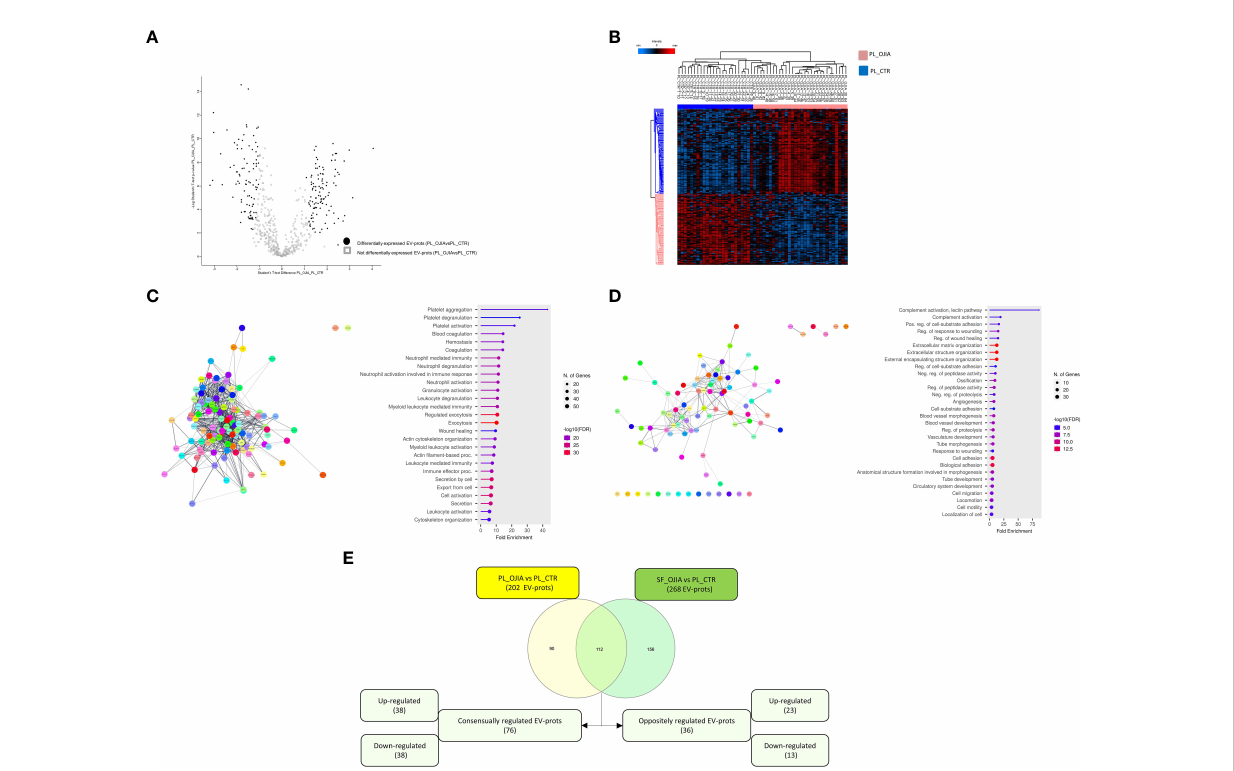
FIGURE 5 Comparative analysis of EV-prot expression pro fi les between PL_OJIA and PL_CTR specimens. EV-prot expression pro fi les were compared between the full sets of PL samples from new-onset OJIA patients and CTR children, and differences in the expression patterns were de fi ned. Differentially expressed EV-prots were subjected to network and functional enrichment analyses. (A) Volcano plot shows differentially expressed EV-prots between the two groups of samples. EV-prot expression levels are indicated as described in the legend of Figure 3B. On the left EV-prots downregulated and on the right those up-regulated in PL_OJIA respect to PL_CTR samples are shown. (B) Heat-map representation shows unsupervised hierarchical clustering analysis of signi fi cantly differentially expressed EV-prots in PL_OJIA vs PL_CTR samples. EV-prot expression levels are indicated as described in the legend of Figure 3B. The pink and blue bars above the columns distinguish the OJIA and CTR groups. The optimal association between two main clusters of EV-prots (indicated by the pink and blue bar on the left side) identi fi ed by the unsupervised hierarchical method and the PL_OJIA and PL_CTR groups of samples is shown. (C, D) Network and pathway enrichment analyses were carried out on up- (C) and down- (D) regulated EV-prots. Interaction networks among EV-prots and GO enriched biological processes are depicted as described in the legend of Figures 3C, D. (E) Venn diagram shows the number of common and exclusive differentially expressed EV-prots detectable in paired SF_OJIA and PL_OJIA respect to PL_CTR specimens. Each comparison is depicted by a distinct color. Common EV-prots displaying consensual and opposite modulation are indicated. Both up- and downregulated EV-prots were considered. The signi fi cance of the overlapping was estimated with hypergeometric